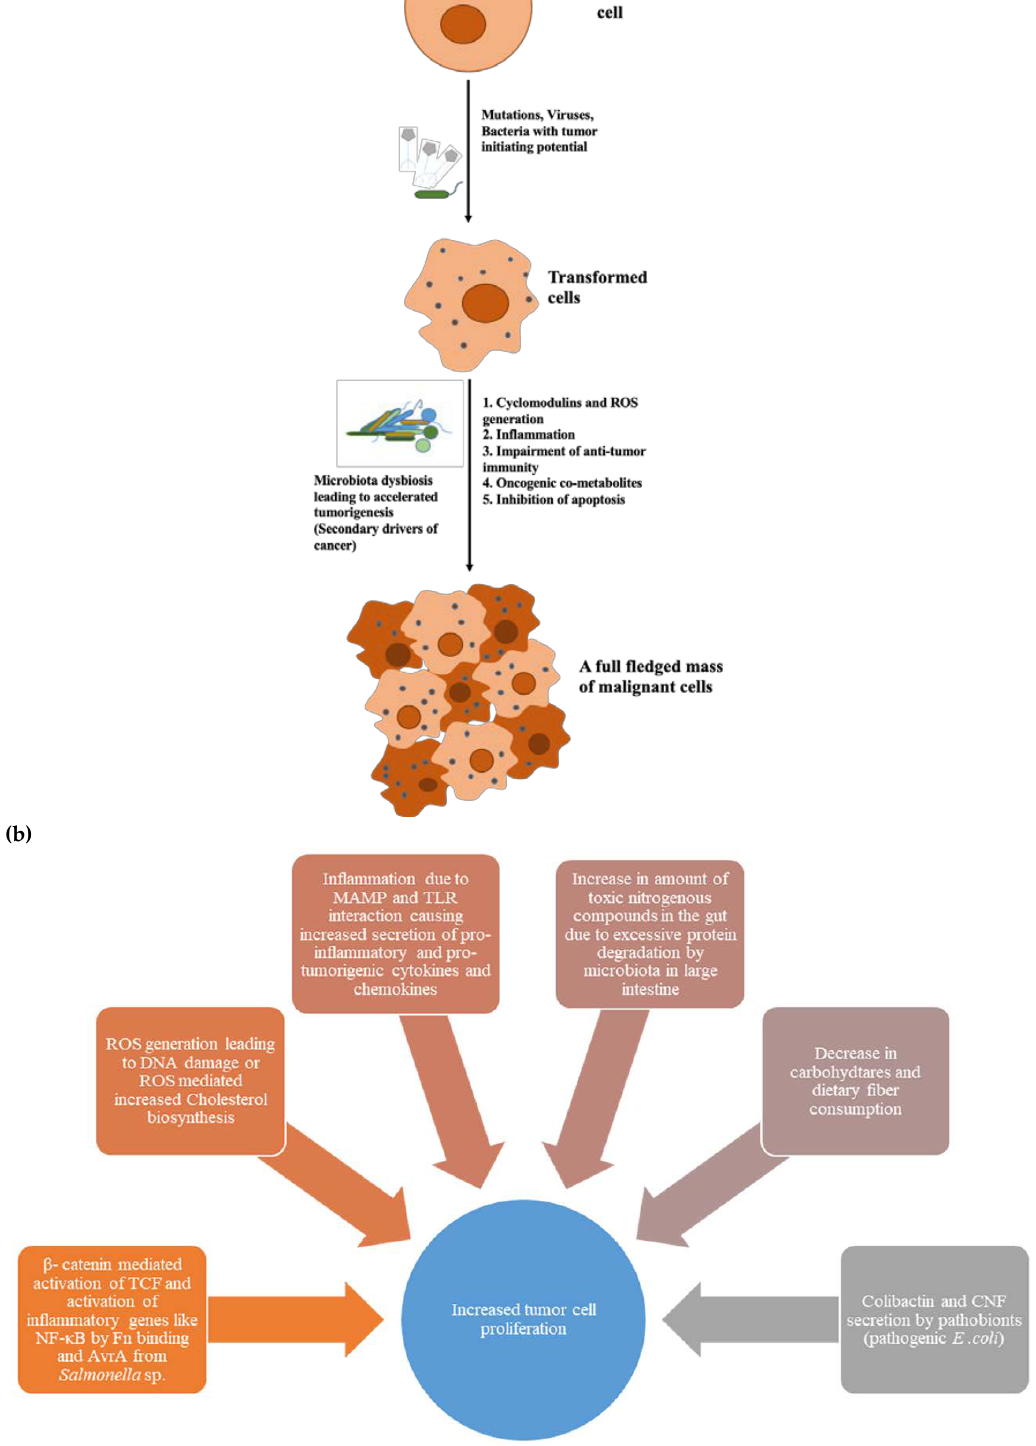
Figure 2. Overview of microbiota-driven cancer. ( a ) Microbiota acts as secondary driver in tumourigenesis, ( b ) factors increasing the tumor cell proliferation.